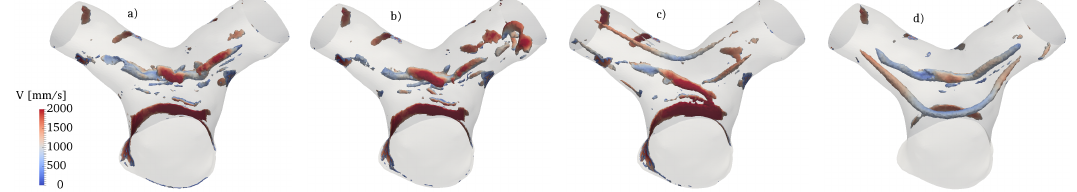
Figure A4. Comparison of Q-criterion, colored by velocity magnitude, at peak systole for different inflow conditions. ( a ) plug flow profile; ( b ) plug flow with swirl component of 10%; ( c ) plug flow with swirl component of 30%; ( d ) Poseuille-like